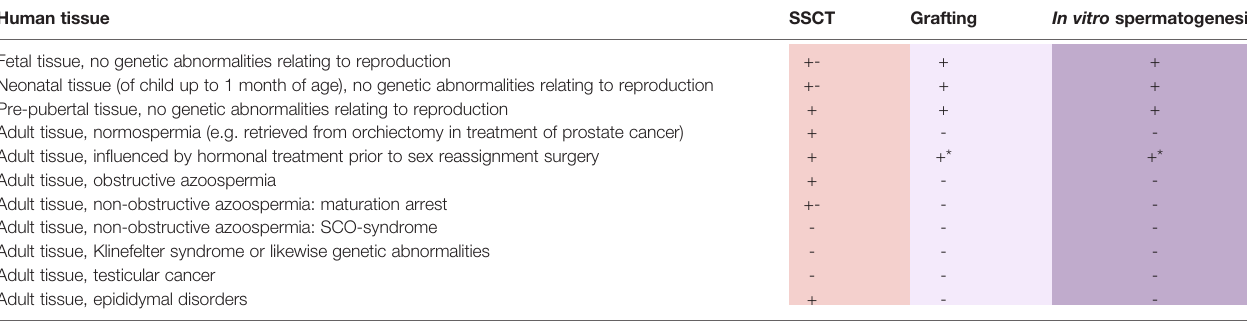
TABLE 1 | Suitability of various testicular tissues as sources for preclinical research on fertility restoration techniques. Human tissue SSCT